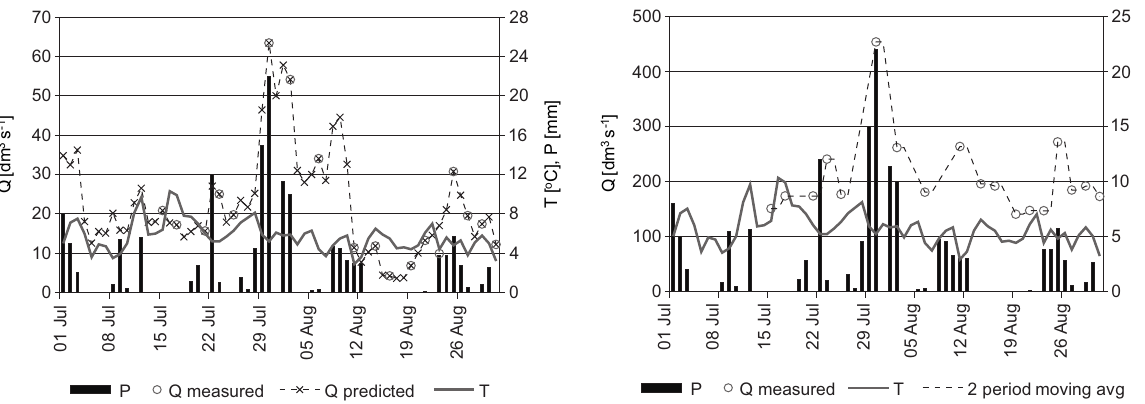
Fig. 4. Discharge (Q) in the stream leaving the CT-2 study Fig. 5. Discharge (Q) in the stream of the CT-2 + CT-3 study catchment in relation to air temperature (T) and precipita- catchments in relation to air temperature (T) and precipita- tion (P) in the period 1.07–5.09.2004 tion (P) in the period 1.07–5.09.2004 Table 2. Meteorological and hydrological characteristics of the investigated river catchments in the area of